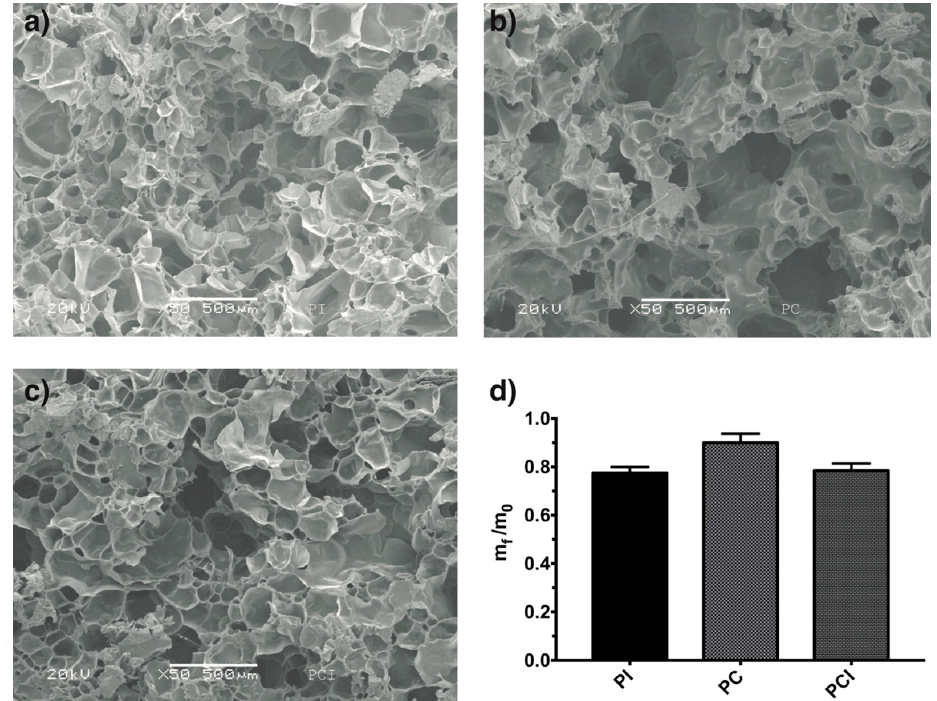
Figure 1. Scanning Electron Microscopy SEM images at 50× for blends materials; ( a ) blend with inulin; ( b ) blend with chitosan and ( c ) blend inulin/chitosan, all samples were synthesized at 353.15 K; and ( d ) weight loss on mechanical stirring testaccording ASTM D-2042 norm.